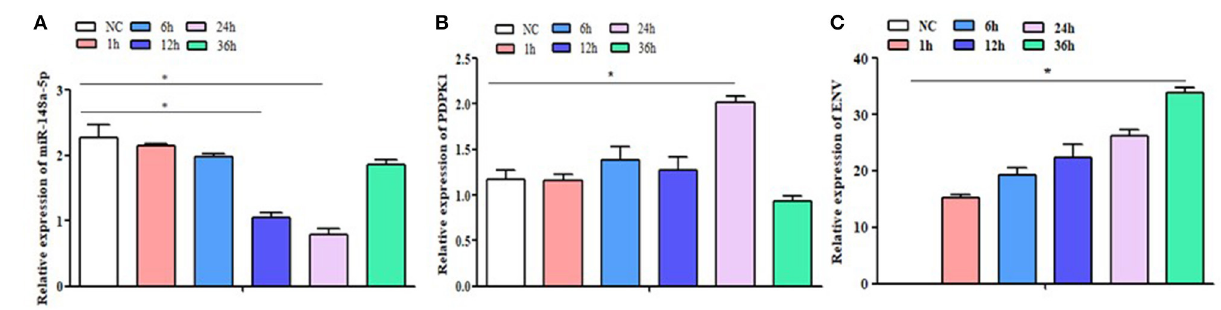
FIGURE 4 | NC: the control group without ALV-J virus infection; 1h, 6h, 12h, 24h and 36h: the different time after infection with ALV-J virus. The expression level of gga-miR-148a-5p, PDPK1 , and ENV gene in the CEF cells at different infection times. Significant differences in gene expression levels between control and